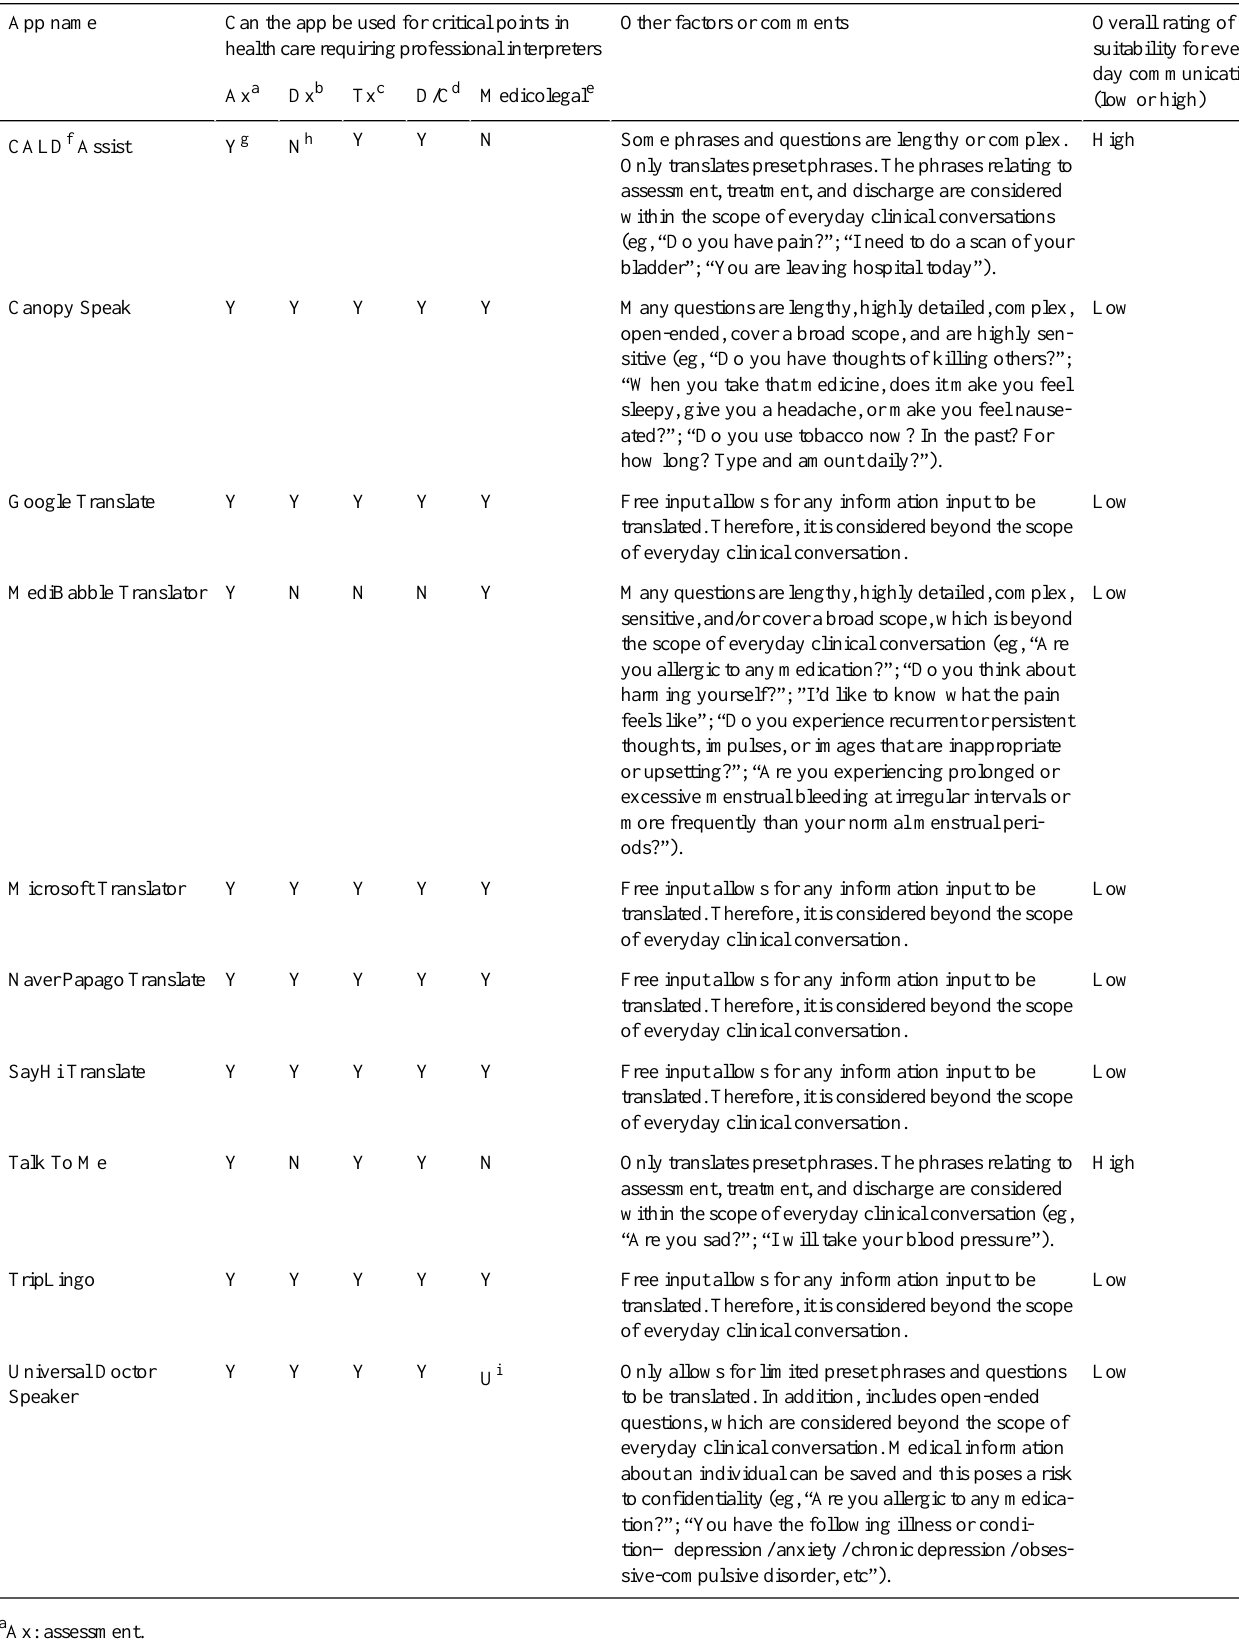
Table 1. Analysis of suitability for everyday conversations in the health care setting.